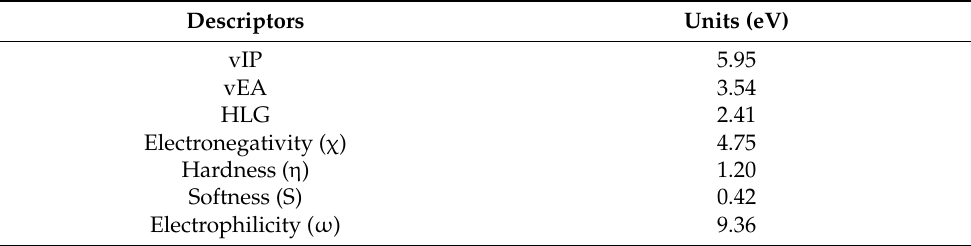
Table 1. Molecular descriptors of